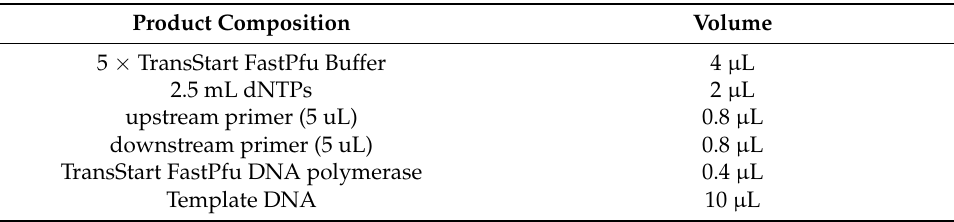
Table 2. PCR reaction